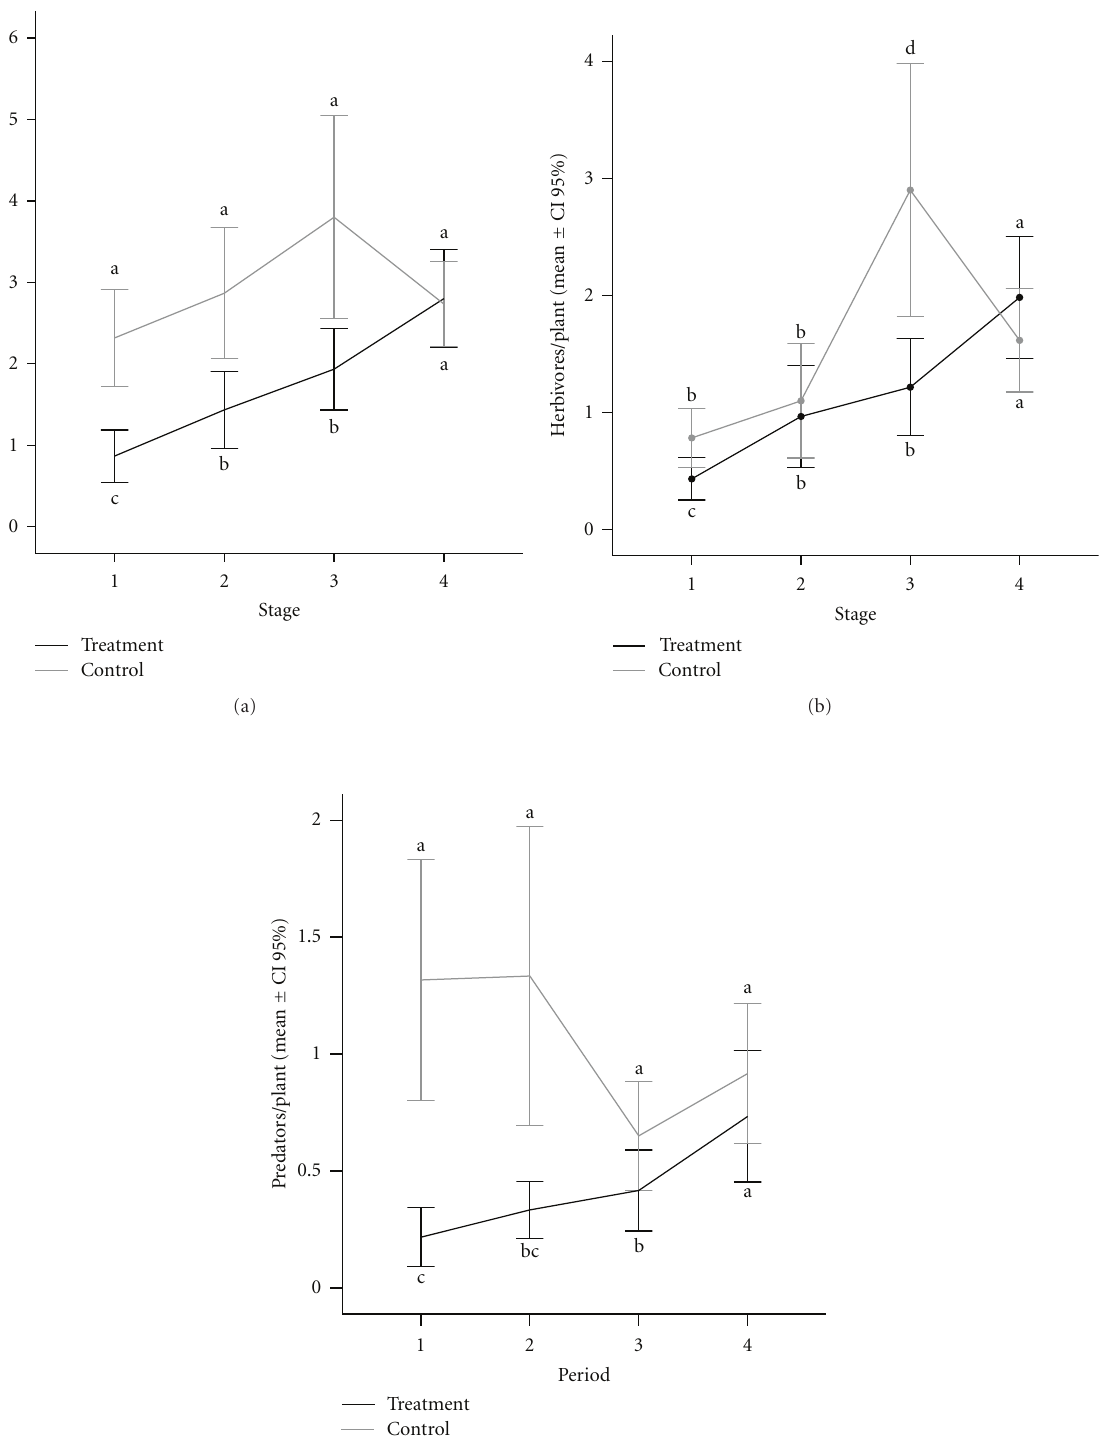
Figure 6: Mean occurrence of the whole nonants arthropods (a) and for herbivores (b) and predators (c) separately, registered in the experimental groups (lines) at each period ( x axis). These arthropods respond positively to decrease occurrence of ants and consequently the absence of C. pugionata (ANOVA: nonants arthropods: F (3;354) = 3.62; P < 0 . 01; Herbivores: F (3;354) = 3.21; P < 0 . 01; Predators: F (3;354) = 4.66; P < 0 . 01). Di ff erent letters indicate significant di ff erences according to post hoc test (LSD: P < 0 .